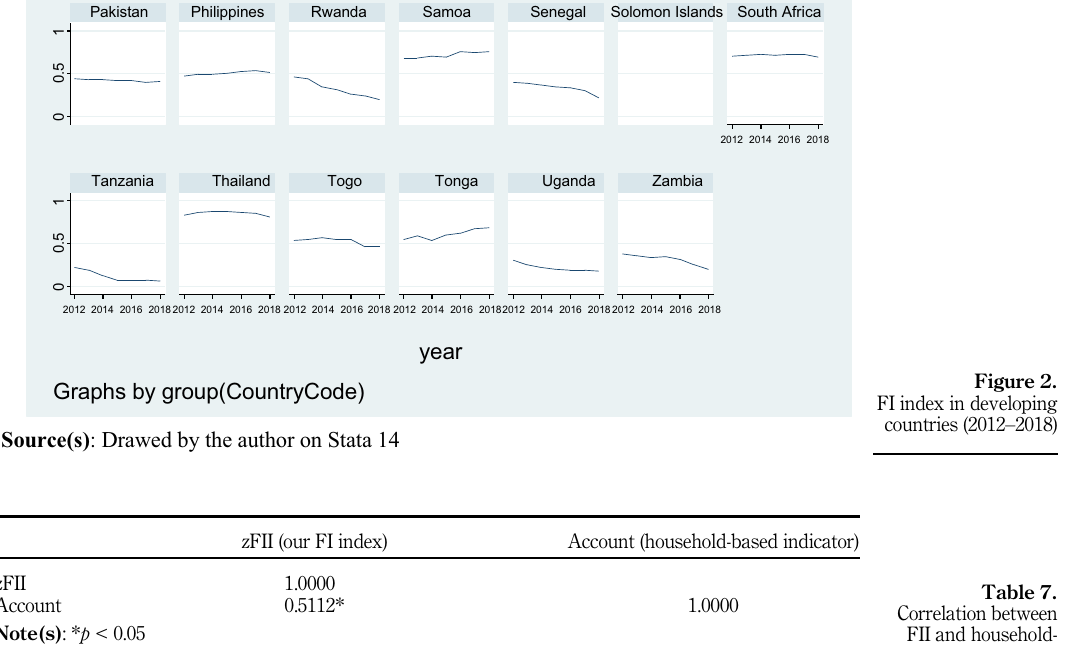
Table 7. Correlation between FII and household- based